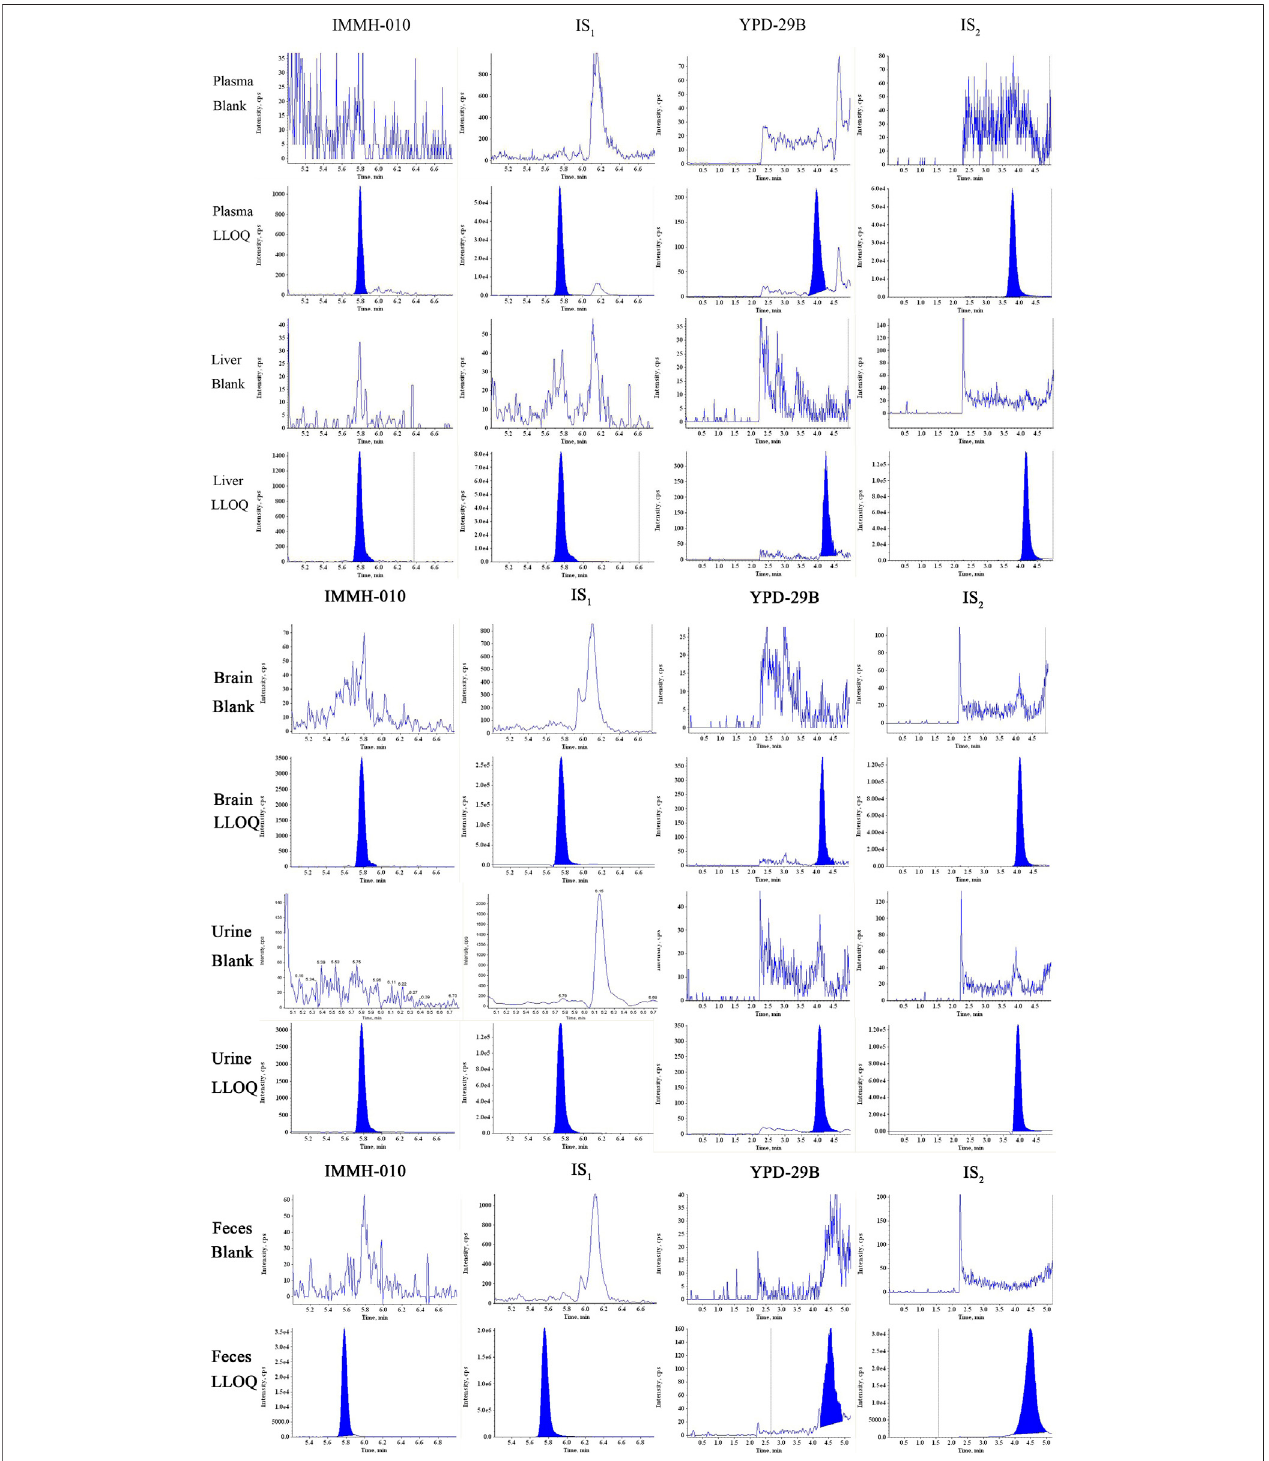
FIGURE 2 | Typical MRM chromatograms of IMMH-010, IS 1 , YPD-29B and IS 2 in plasma, liver, brain and urine and feces obtained from blank sample and LLOQ samples.